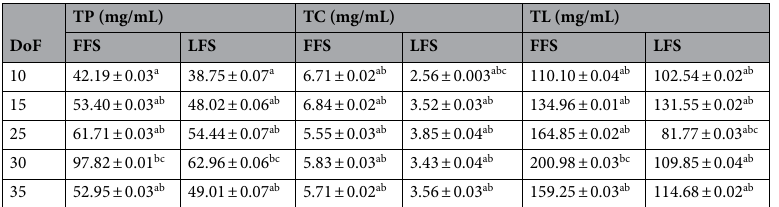
Table 1. Changes in the concentrations (mg/mL) of total protein (TP), total carbohydrate (TC) and total lipid (TL) in supernatant of two silages prepared from fat fish (FFS) and lean fish (LFS) during 35 days of fermentation (DoF). Values (mg/mL) are mean ± SE. Different superscript letters of biochemical constituent in the same column and paired comparison between FFS and LFS indicate significant difference between DoF ( p <